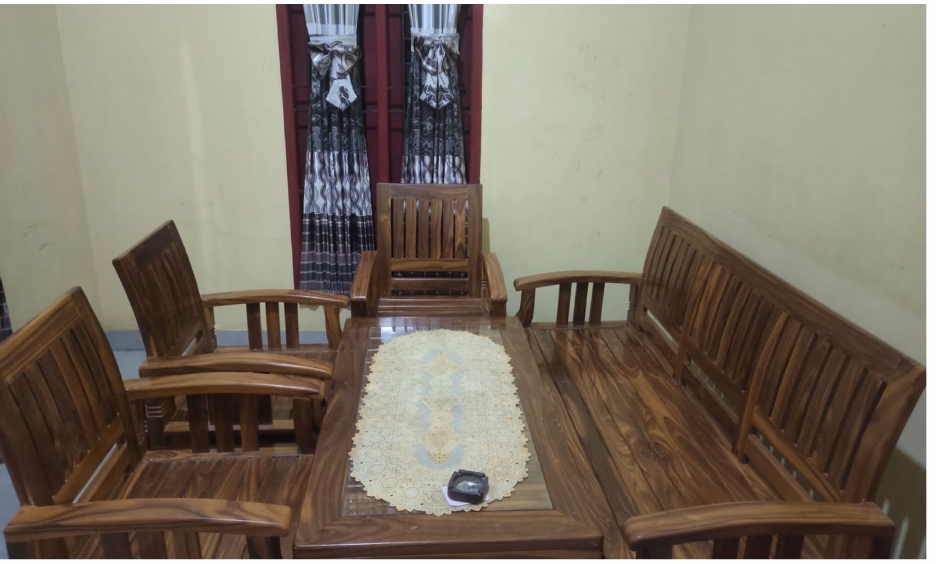
Figure 8. Wood product of P. mooniana from Southeast Sulawesi, Indonesia (Photo: F.D. Tuheteru,